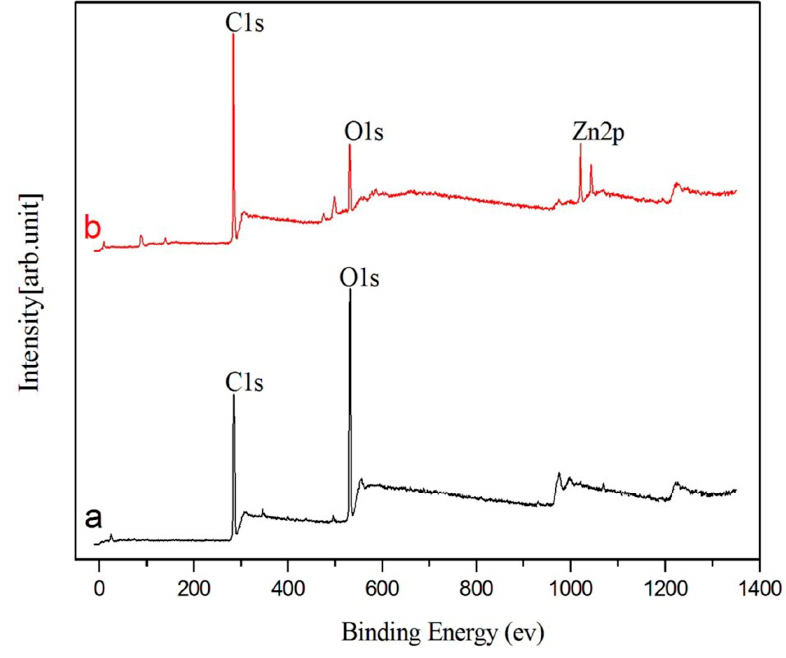
Figure 5. XPS spectra of the ( a ) pristine wood flour and ( b ) as-prepared wood flour.